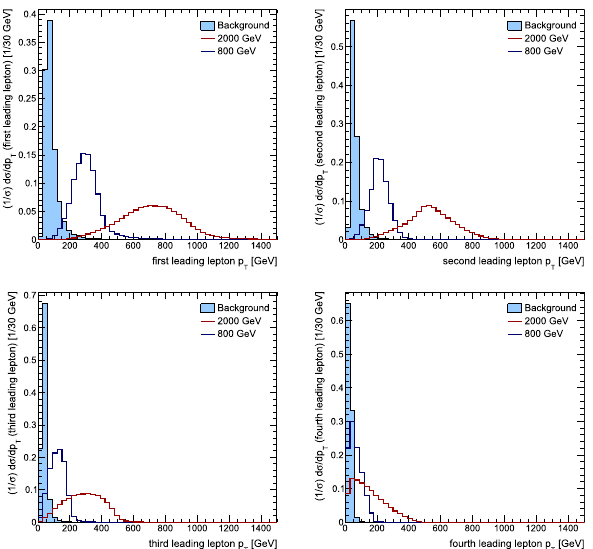
Fig. 9 Normalizeddifferentialcrosssectionsasafunctionofthetrans- verse momentum of Z 1 boson ( a ) Z 2 boson ( b ), and the invariant = 2000 GeV (red line), mass ( c ) and transverse momentum ( d ) of the four-lepton system for √ 2 = 2000 GeV (red line), 800 GeV (blue line) and background (blue m h s = 14 TeV √ 2 s = 14 TeV solid) at